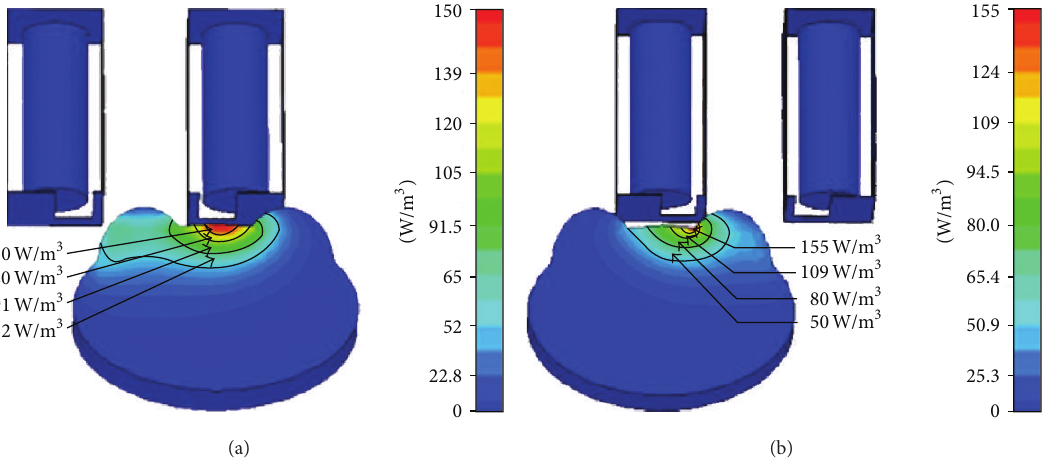
Figure 7: Electric loss density of the heating model for changing both ferrite cores with rectangular shields in 𝑥 -direction. (a) The orientation of both ferrite cores with rectangular shields changed from original position to the 8cm and (b) the orientation of both ferrite cores changed from the original position to 16cm.